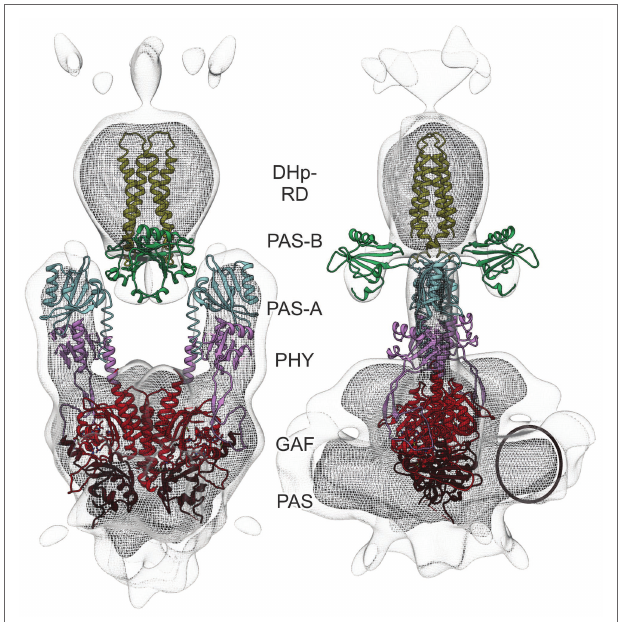
FIGURE 5 | Docking of PCM and CTM domains into the cryo-EM electron density map of At phyA. The Per-ARNT-Sim (PAS), cyclic GMP, adenylyl cyclase, FhlA (GAF), and phytochrome-specific (PHY) domains of the PCM are shown in brown, red, and pink, respectively. Additional density in the bottom part of the map (circle) can be ascribed to the NTE. Within the CTM, the PAS-A, PAS-B, and DHp-RD domains are displayed in cyan, green, and yellow, respectively. For details of the modeling, see main